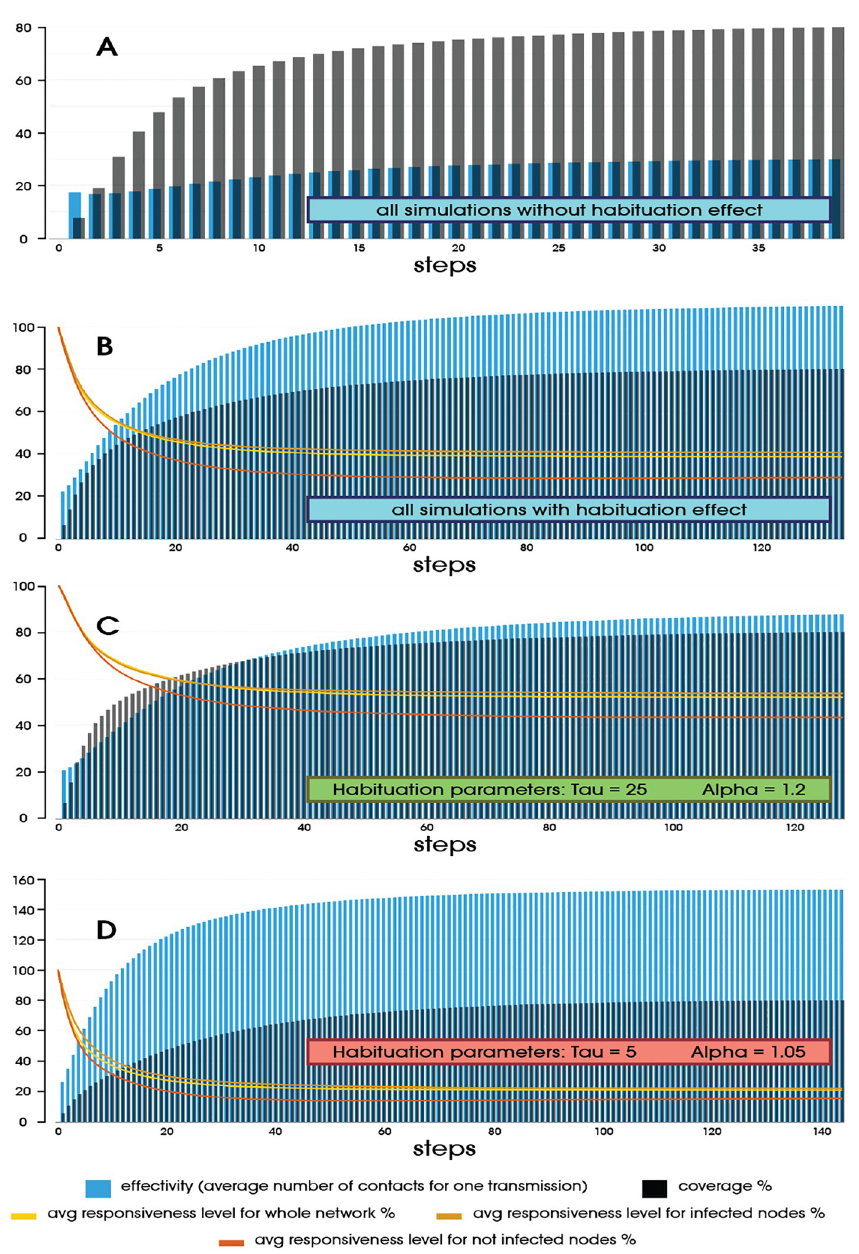
Fig 2. Example illustrating the impact of a drop in responsiveness on process